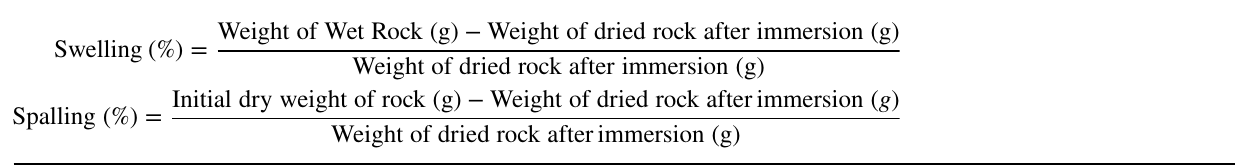
Fig. 6 Effect of NaCl, KCl and haematite on yield point of CMC– bentonite